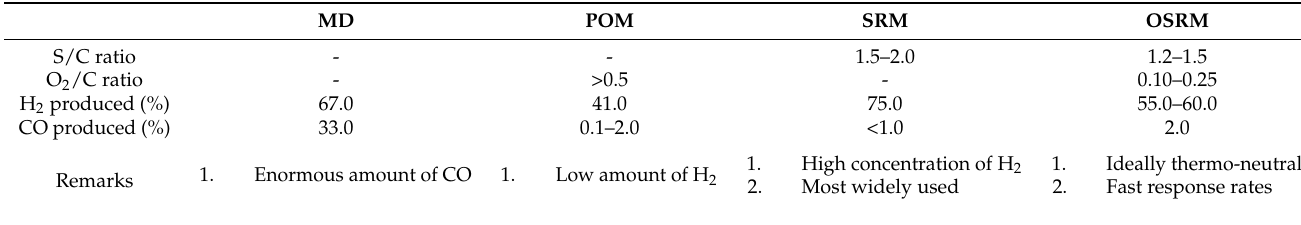
Table 1. Typical characteristics of the referred reforming processes of methanol for hydrogen